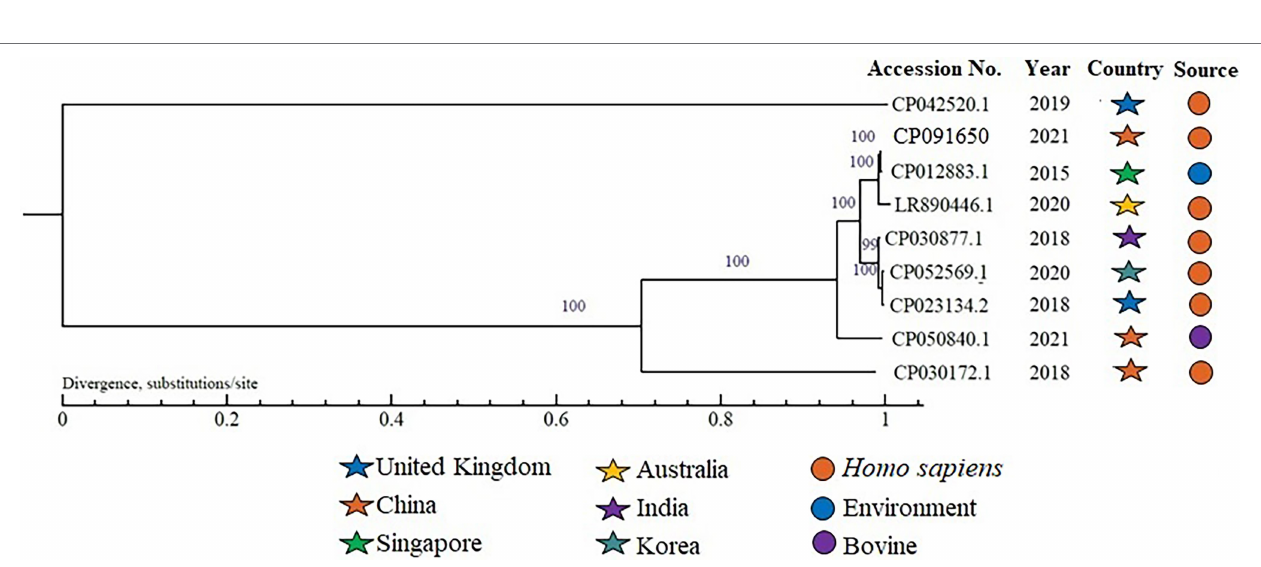
FIGURE 3 | The survival rate of mouse infected by three hypervirulent Klebsiella pneumoniae (hvKP) isolates. Klebsiella pneumoniae ATCC 13883 served as the control.